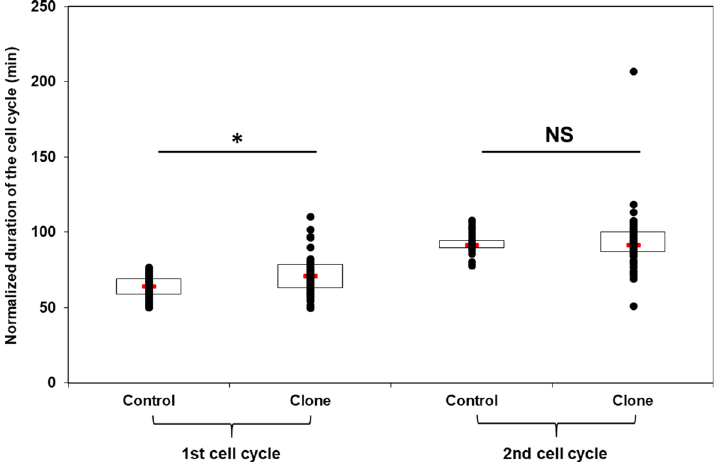
Figure 2. Duration of the first and second cell cycle after nuclear transfer. Fertilized controls and clones individual values were standardized according to the controls mean value (first cell cycle = 63.6 min, second cell cycle = 92.3 min post fertilization) to compensate for spawn variability. Red rectangle = median; open rectangle = first + third quartile; black point = embryo. Cell cycle duration was measured on n = 68 fertilized controls and n = 54 clones obtained from 3 different spawns. *Significant differences (p < 0.05) between controls and clones. NS not